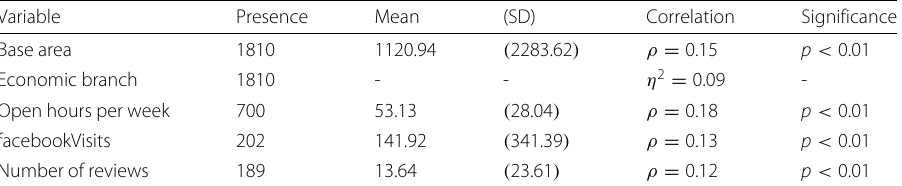
Table 2 Open big data variables with presence for the company locations, descriptive statistics and the correlation with normalized electricity consumption (log) Variable Presence Mean (SD) Correlation Significance Base area 1810 1120.94 ( 2283.62 ) ρ = 0.15 p < 0.01 Economic branch